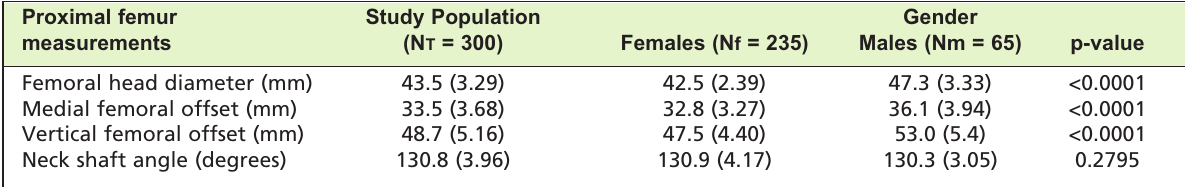
Morphological measurements – comparing gender Table I: